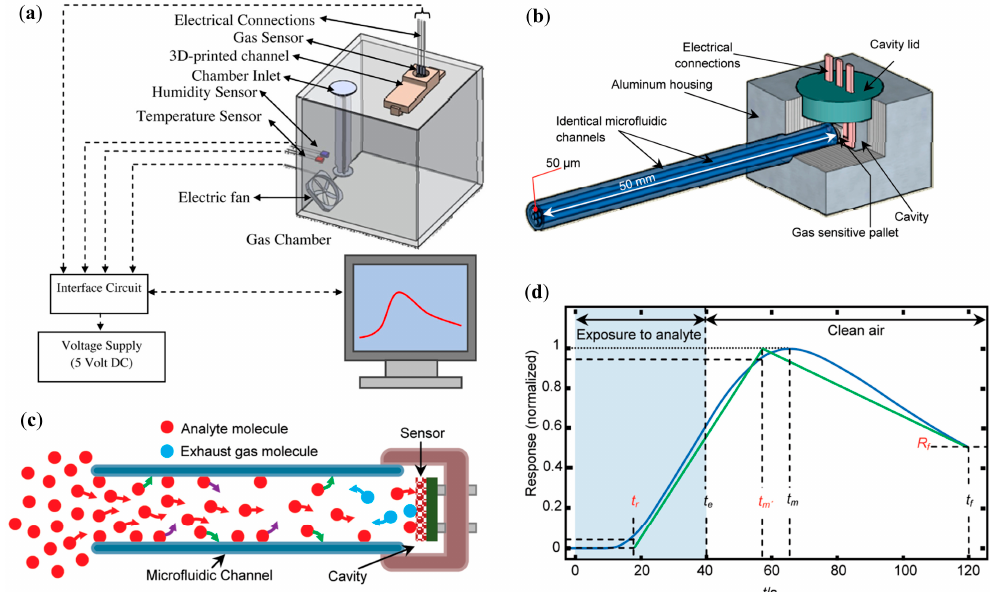
Figure 1. Structures composing the device and line diagram. ( a ) Schematic of the experimental setup. ( b ) Channel-sensor coupling. ( c ) Analyte diffusion along one channel. The red, green, violet, and blue arrows illustrate the diffuse-in, physisorption, desorption, and diffuse-out processes, respectively. ( d ) An experimental normalized response profile and its “line diagram”. The line diagram is specified by determining tr and tm ′ , moments where the response profile reaches 5% and 95% of its maximum level, respectively, and Rf, the dimensionless magnitude of the profile at tf. ( a ) Reproduced with permission. [17] Copyright 2017, Elsevier. ( b – d ) Reproduced with permission from [15] Copyright 2010, American Chemical Society.